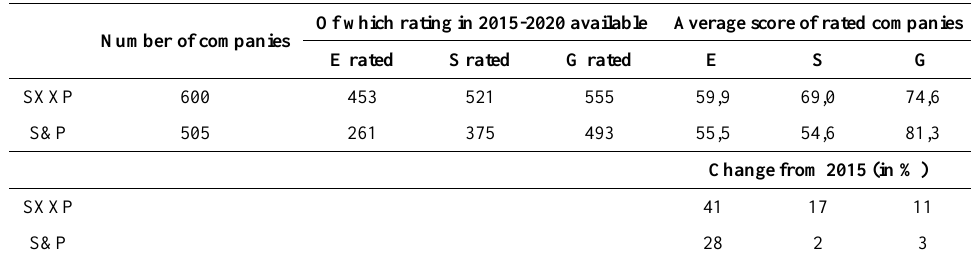
Table 2. Basic statistical information of the data